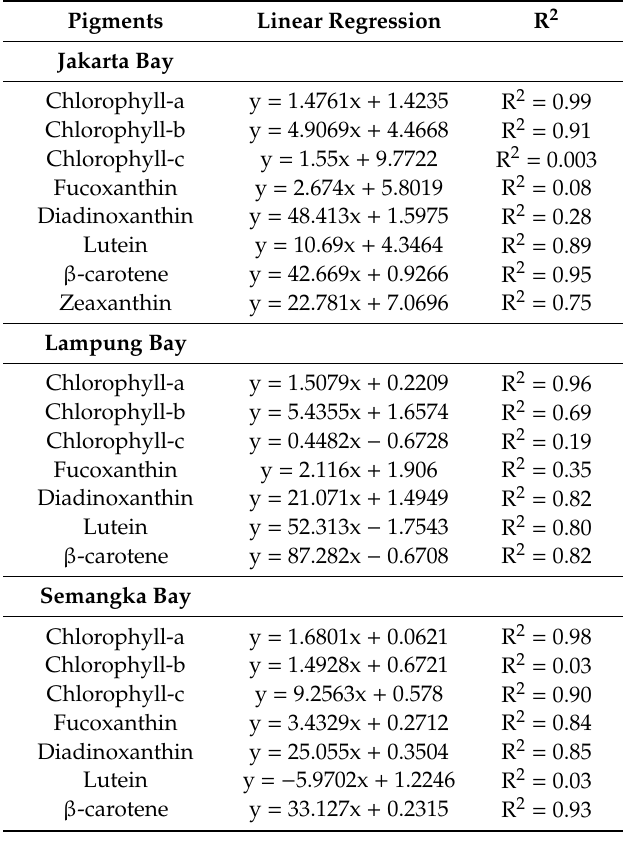
Table 1. Linear regression analysis between each pigment to total pigments. Pigments Linear Regression R